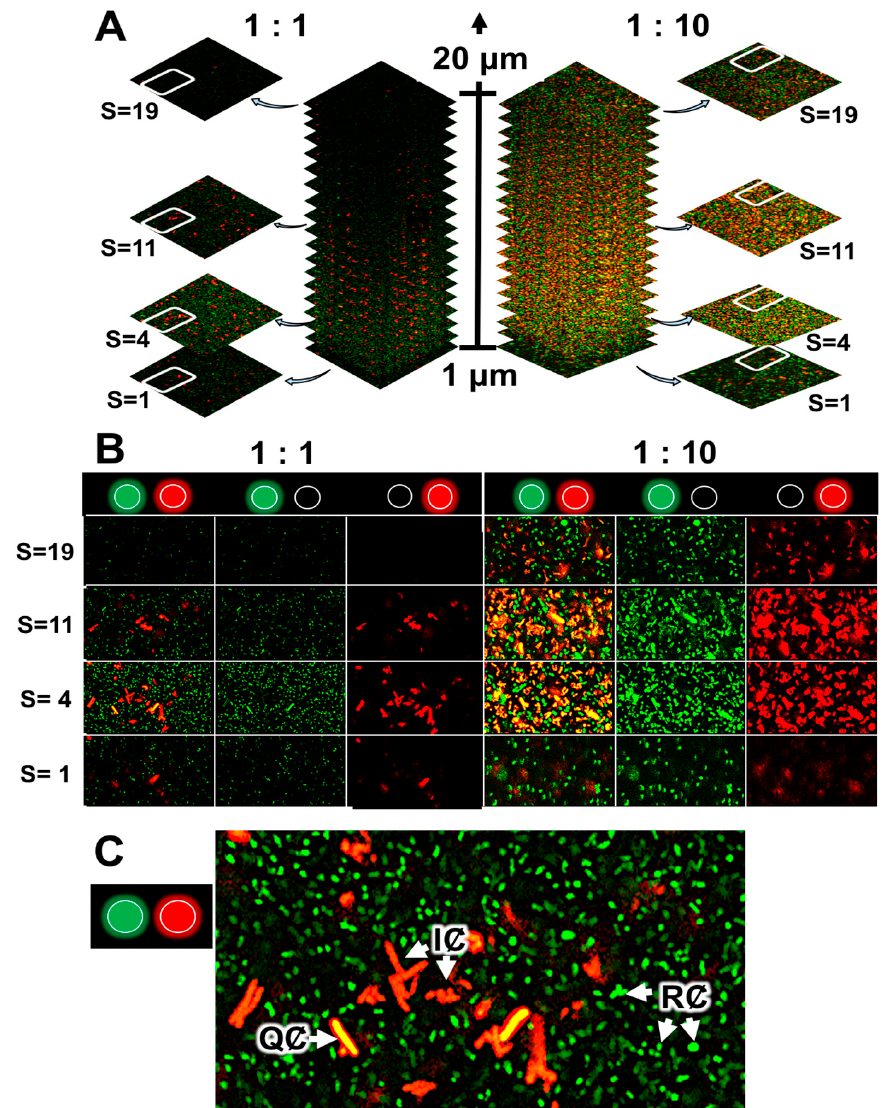
Figure 4. CLSM analysis of quorum-quenching activity in a dual-species biofilm of R. rhizogenes and R. erythropolis. R. rhizogenes (green fluorescence) was tagged with GFP via the pHC60- gfp . R. erythropolis was transformed with the pEPR1- qsdR -P qsd::gfp-mCherry vector containing a transcriptional fusion between the promoter of the AHL lactonase-encoding gene qsdA and the gfp gene for the monitoring of its quorum-quenching activity. ( A ) A total of 19 confocal image stacks acquired with 1 µ m slices from the bottom to the top of the mixed biofilms. For each mixed biofilm (with an R. rhizogenes / R. erythropolis ratio of 1:1 at left or 1:10 at right), four image stacks taken at 1 (S = 1), 4 (S = 4), 11 (S = 11), and 19 (S = 19) µm from the bottom of the biofilm were selected for the assessment of rhodococcal quorum-quenching activity. ( B ) Details delineated by the white circled area of four sample image stacks, previously selected among images in ( A ), to highlight the rhodococcal quorum-quenching activity at the different observation channels. ( C ) Close-up of the selected image stack S = 4 with an R. rhizogenes / R. erythropolis ratio of 1:1. Legend: R , rhizobial cells (green fluorescence), Q , quenching cells sensing and degrading N -acyl-homoserine lactone (AHL) signals (green plus red, i.e., yellow, fluorescence); I , inactive cell not sensing or degrading AHL signals (red fluorescence) (activation of the green or red channel is indicated by a light spot of the corresponding color) . Scale bar represents 5 µ m.